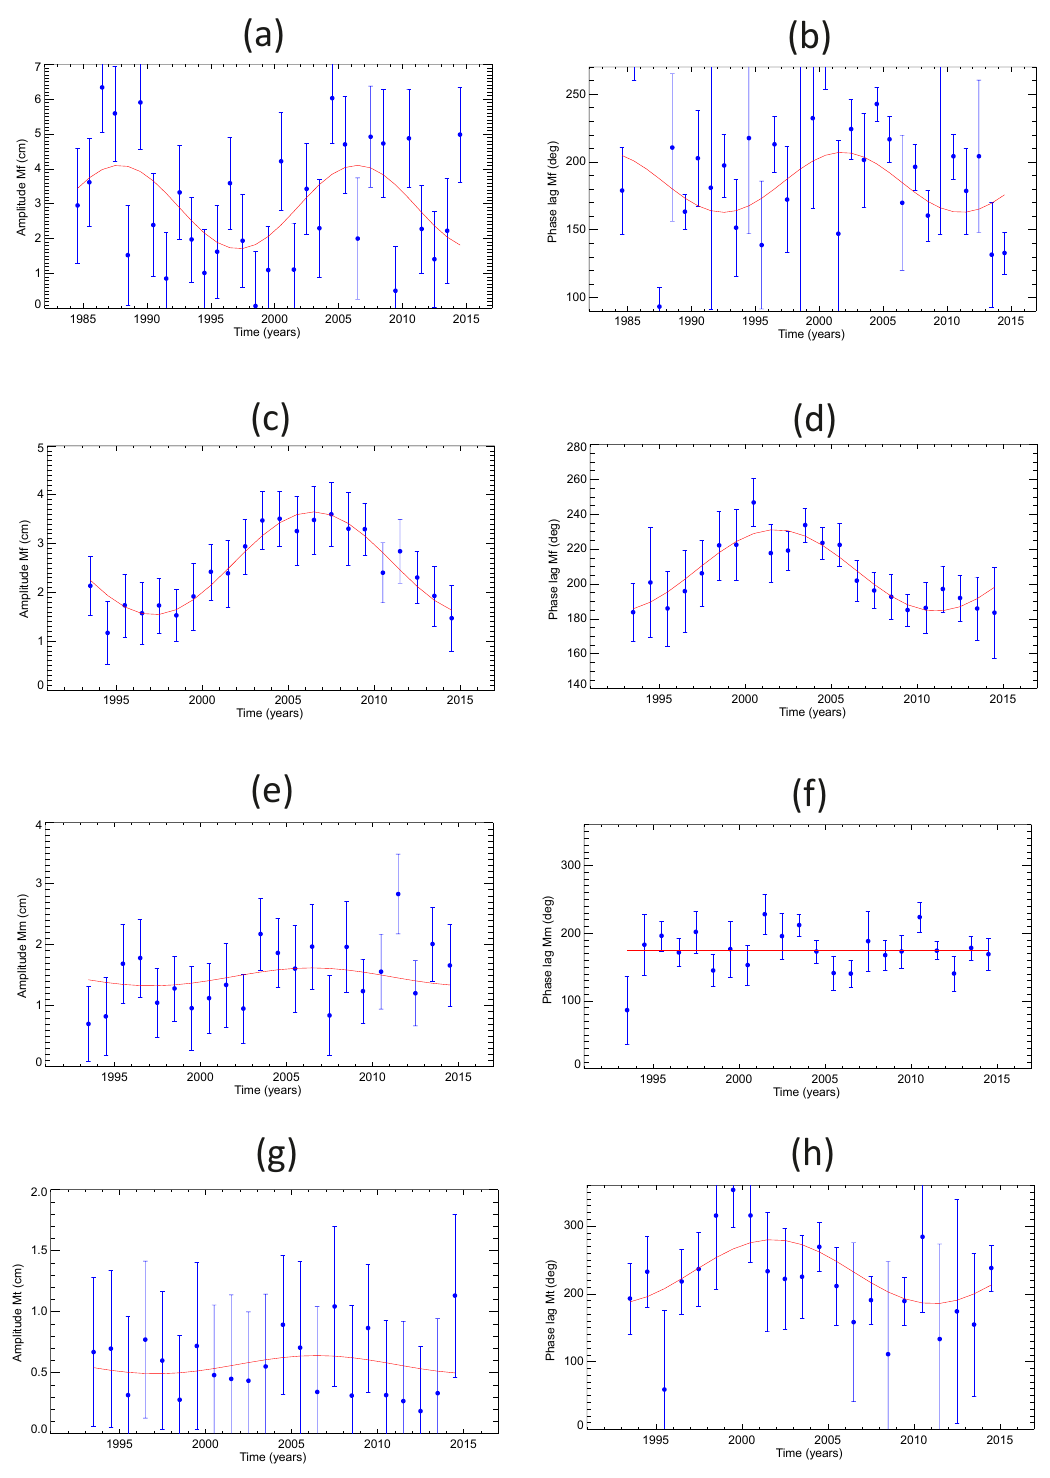
Figure 8. (a) Amplitude (cm) and (b) phase lag (degrees) of Mf obtained from Vernadsky tide gauge data. Panels (c, d) are the same as (a, b) for Mf but using DAC-corrected tide gauge data. Panels (e, f) are the same as (a, b) but for the Mm long-period tide and using DAC- corrected data. The red line in panel (f) indicates the median phase lag instead of a nodal fit. Panels (g, h) are the same as (a, b) but for Mt and using DAC-corrected